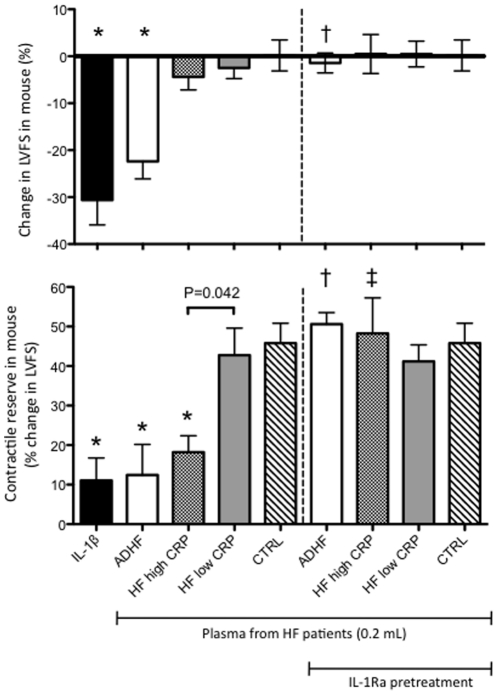
Effects of plasma from HF patients on LV function in healthy mice.Plasma from HF patients (0.2 mL) was injected into healthy mice, follwed by echocardiographic assessment of LV function at 4 hours. Plasma from patients with ADHF induced a 22% reduction in LV fractional shortening (LVFS) in the mouse that was preventable by pretreating the mice with anakinra 100 mg/kg given 30 minutes prior to plasma injection. Plasma from patients with ADHF and HF high CRP reduced contractile reserve in the mouse as measured by LVFS response to isoproterenol. Pre-treating the mice with anakinra 100 mg/kg given 30 minutes prior to plasma injection prevented the reduction in contractile reserve. *P<0.001 versus CTRL, †P<0.05 versus ADHF, ‡P<0.05 versus HF high CRP.